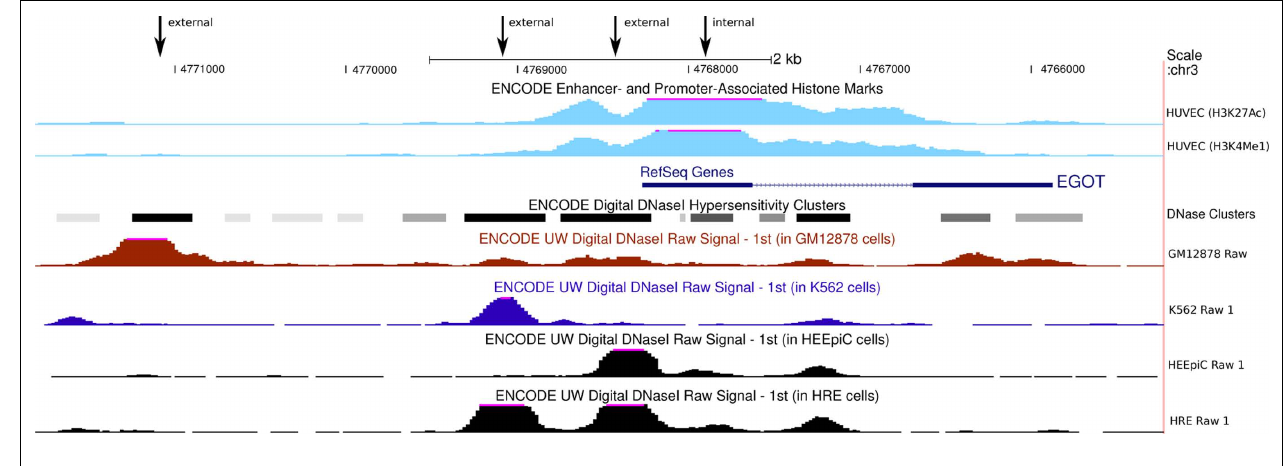
marks suggest an internal promoter at the 5 (cid:2) -exon of EGO-B.The figure contains only exemplary cell lines. However, the depicted signal peaks, especially the DNase1 hypersensitivity peaks, are consistently present in numerous cell lines.